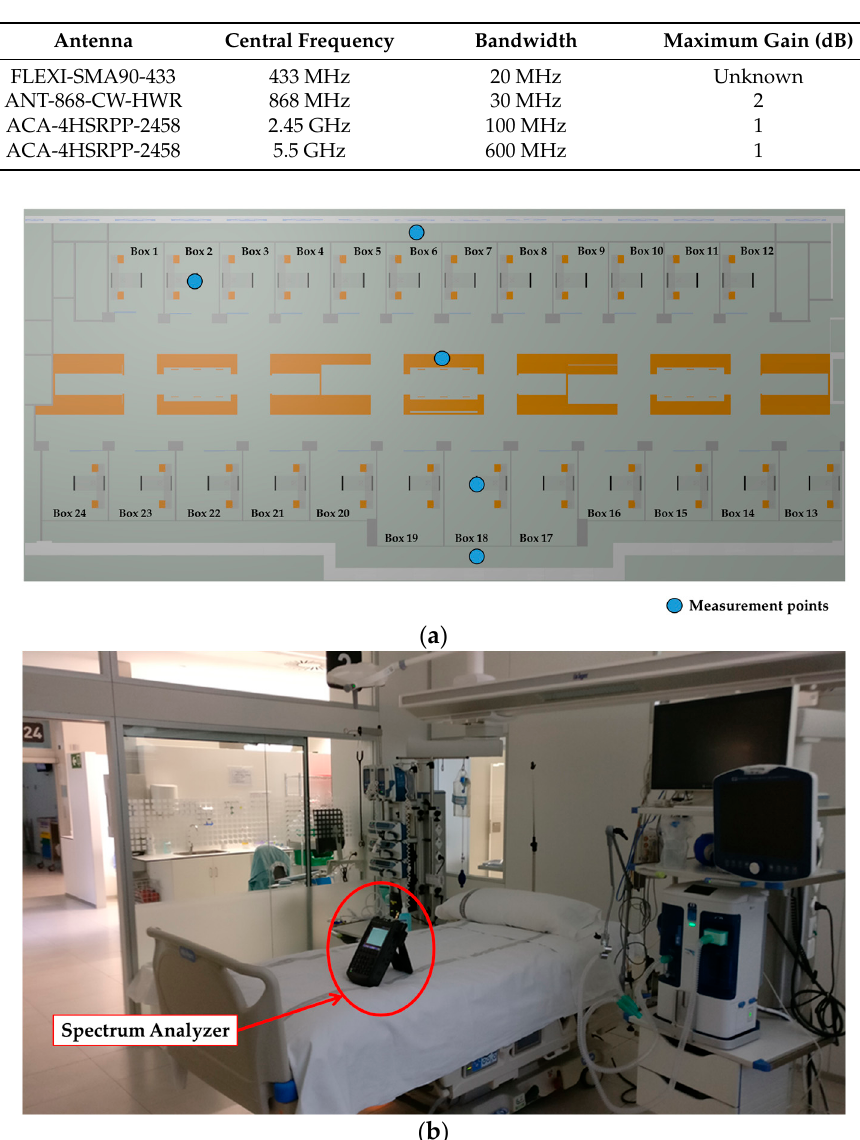
Figure 4. ( a ) Points within the scenario where spectrograms have been measured; and ( b ) the employed FieldFox N9912A spectrum analyzer of brand Agilent (Las Rozas, Spain) within Box 2.